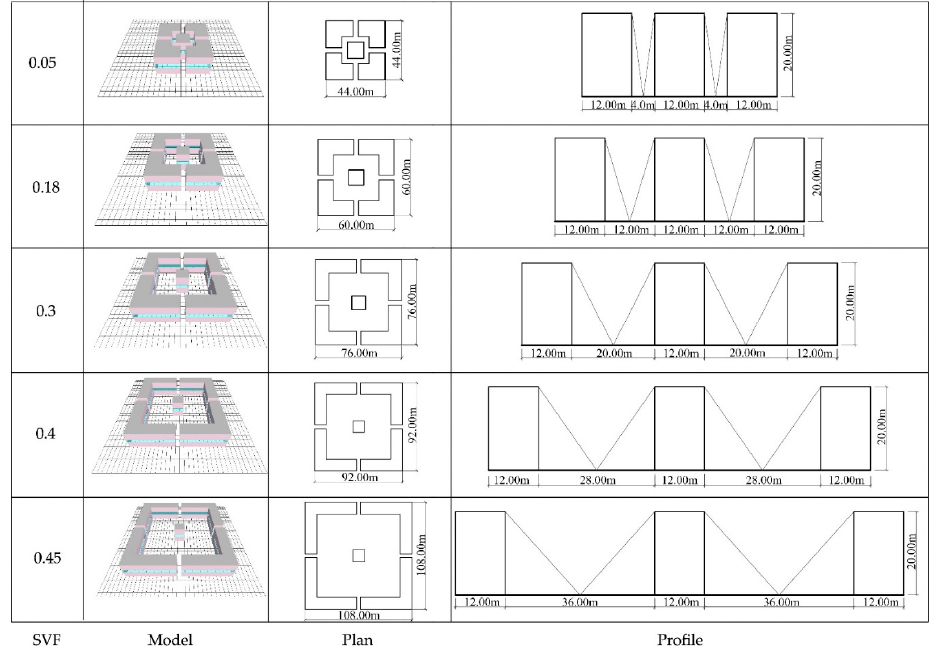
Figure 2. Models with different SVF values.